Question: State the chart type depicted above.
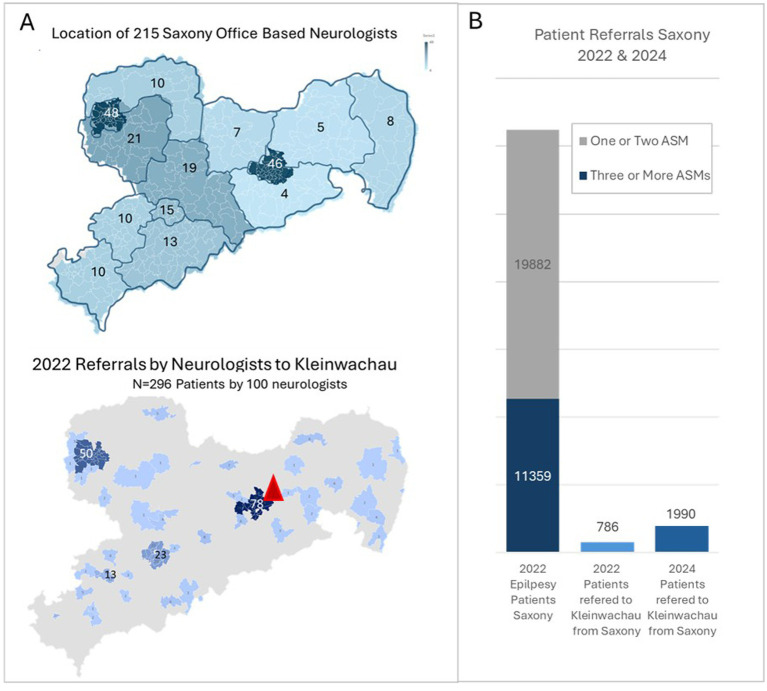
Answer: line